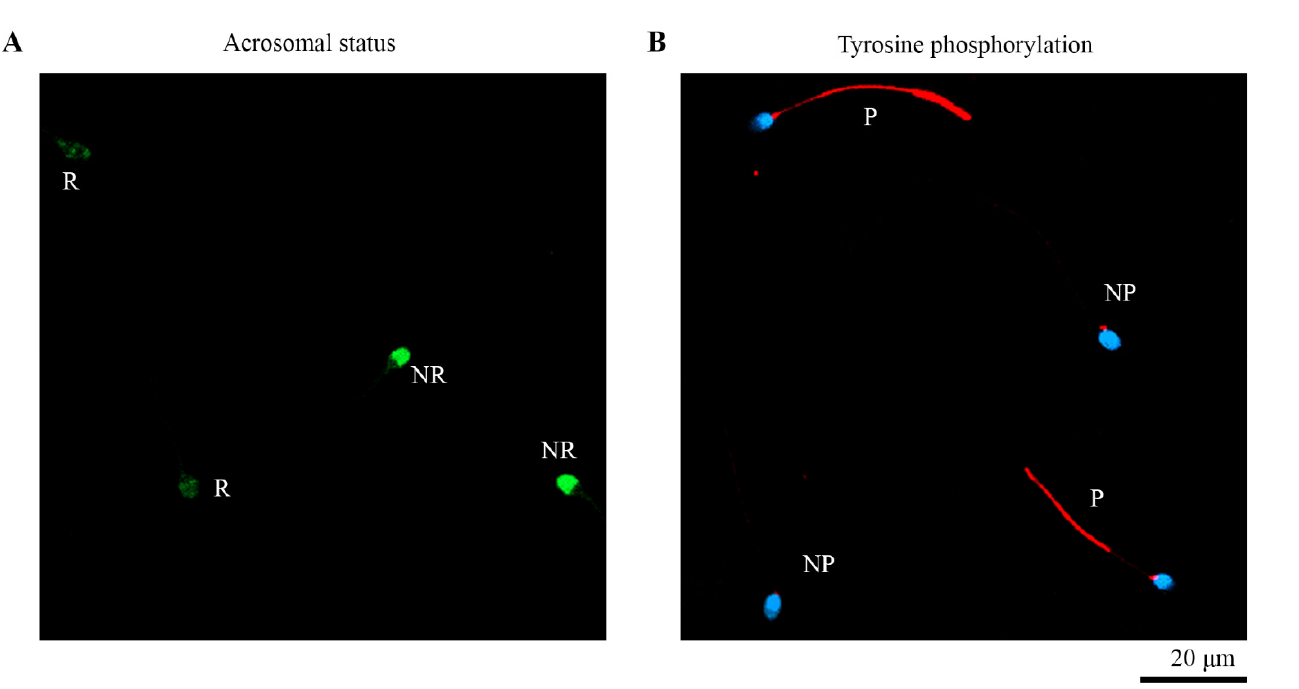
Figure 2. Confocal micrographs of sperm physiological control biomarkers in humans. ( A ) Acrosomal status by PSA-FITC binding label: reacted sperm (R) and non-reacted sperm (NR). ( B ) Tyrosine phosphorylation by PY20 antibody: phosphorylated sperm (P) and non-phosphorylated sperm (NP).